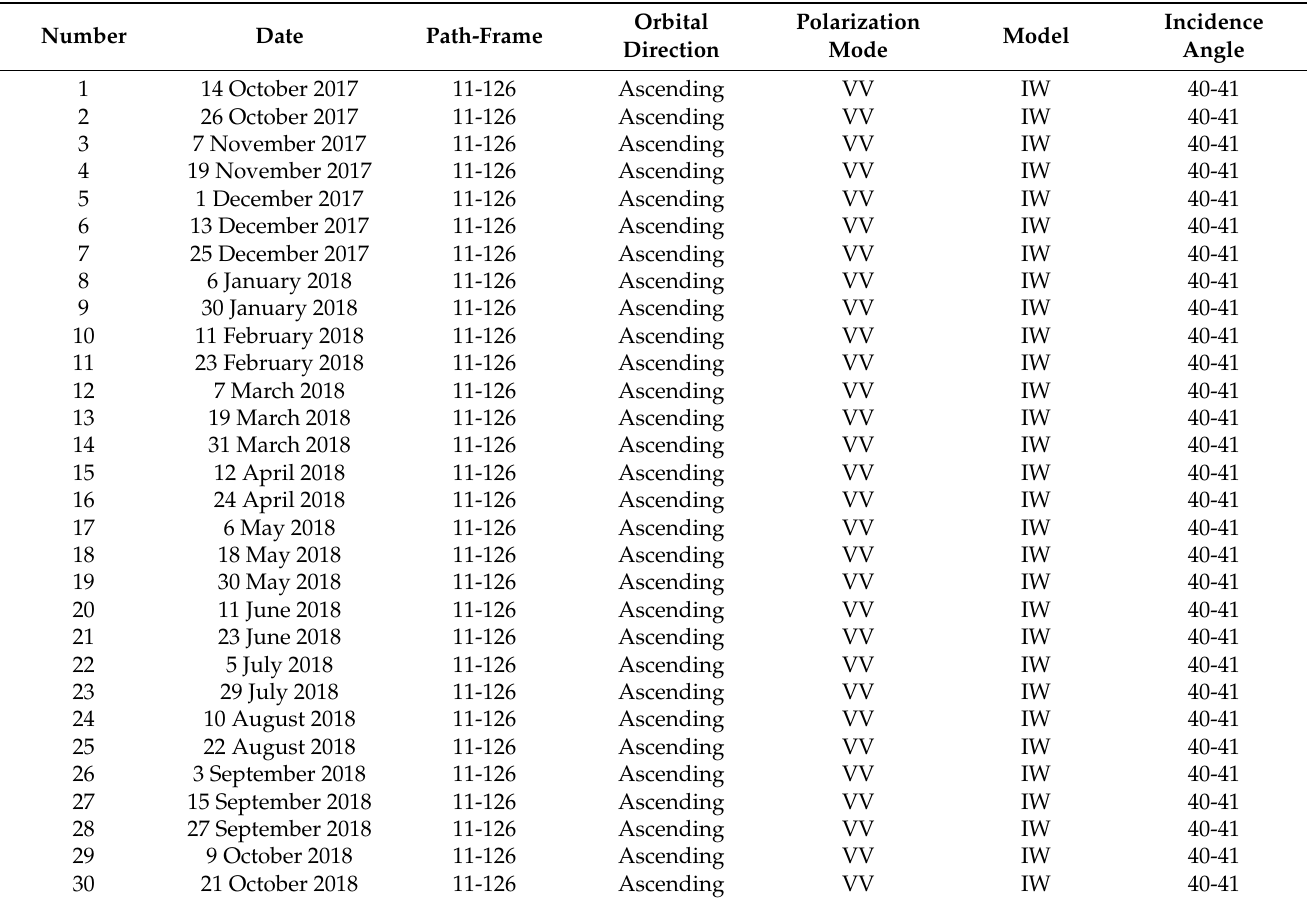
Table 5. Experimental use of SAR image data